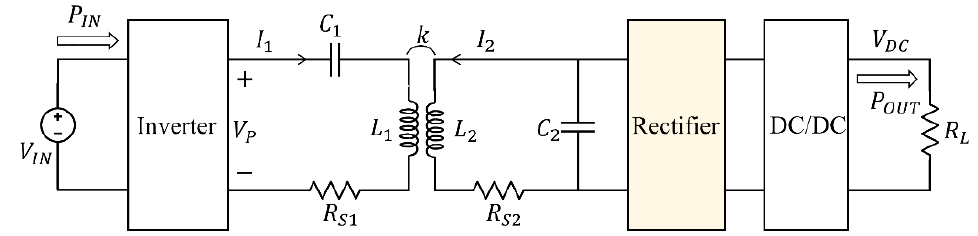
Figure 1. Typical structure of wireless power transfer system for biomedical implants.